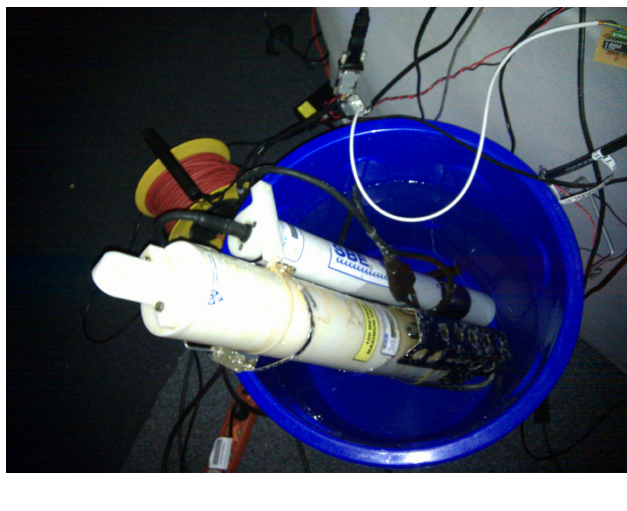
Figure 1. The CTD sensors used in the case